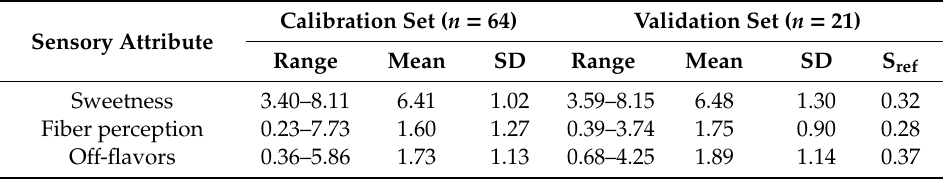
Table 1. Statistics (range, mean, and standard deviation) for the sensory attributes measured by the trained panel in the calibration and validation